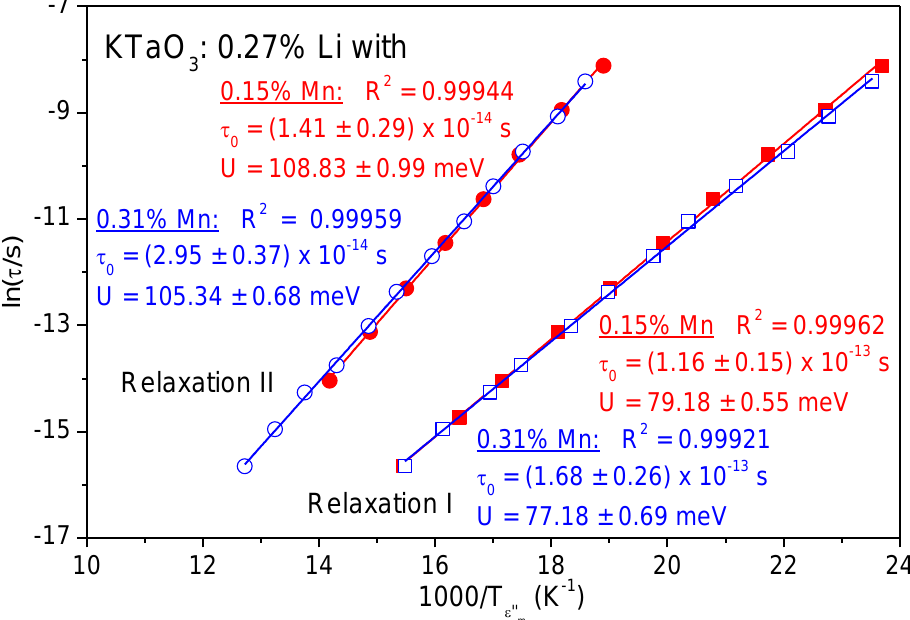
Figure 3. Arrhenius plot ln( τ ) versus 1000 /T ε ” m for the dielectric relaxations I (squares) and II (circles) of KTaO 3 : 0.27% Li + 0.15% Mn (solid symbols) and KTaO 3 : 0.27% Li + 0.31% Mn (open symbols) single crystals with fits to the Arrhenius law (solid lines) and the fit parameters.